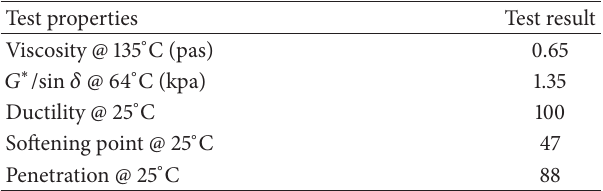
Table 1: Properties of base binder grade 80/100